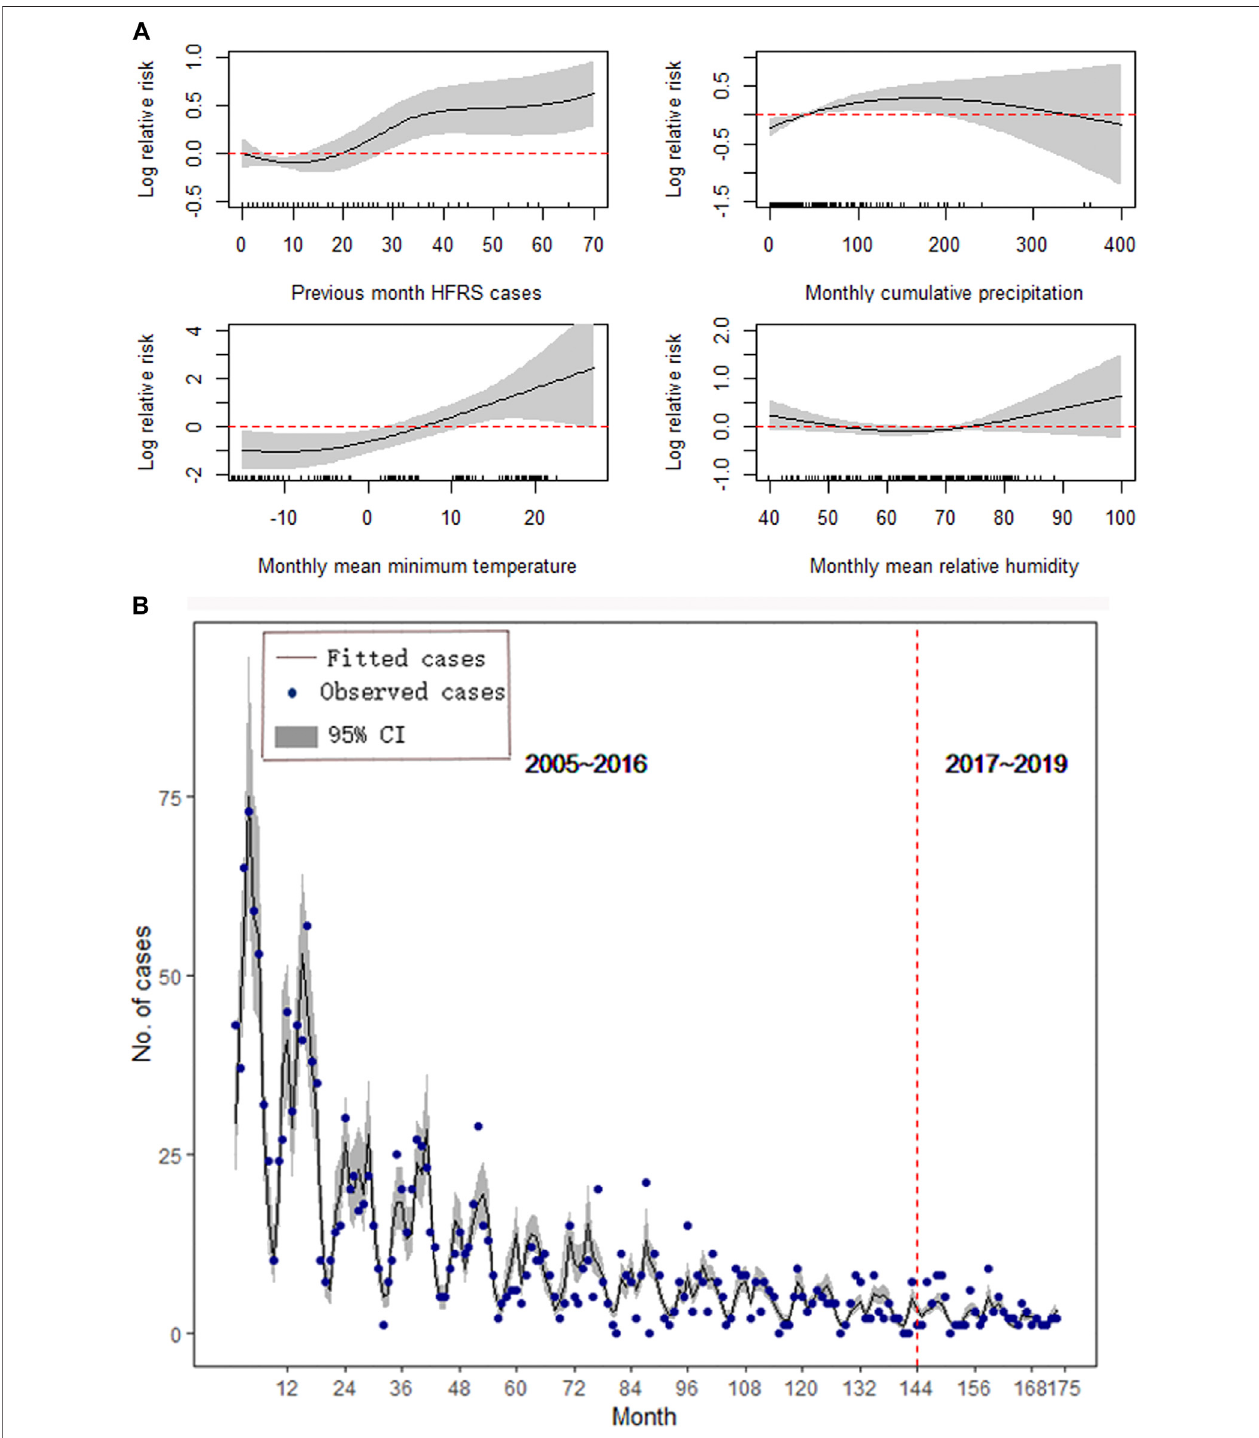
FIGURE 5 | Results of the GAM for Shenyang. (A) The effect of meteorological conditions on the epidemics of HFRS. (B) Forecast and comparison of the fi tted values.